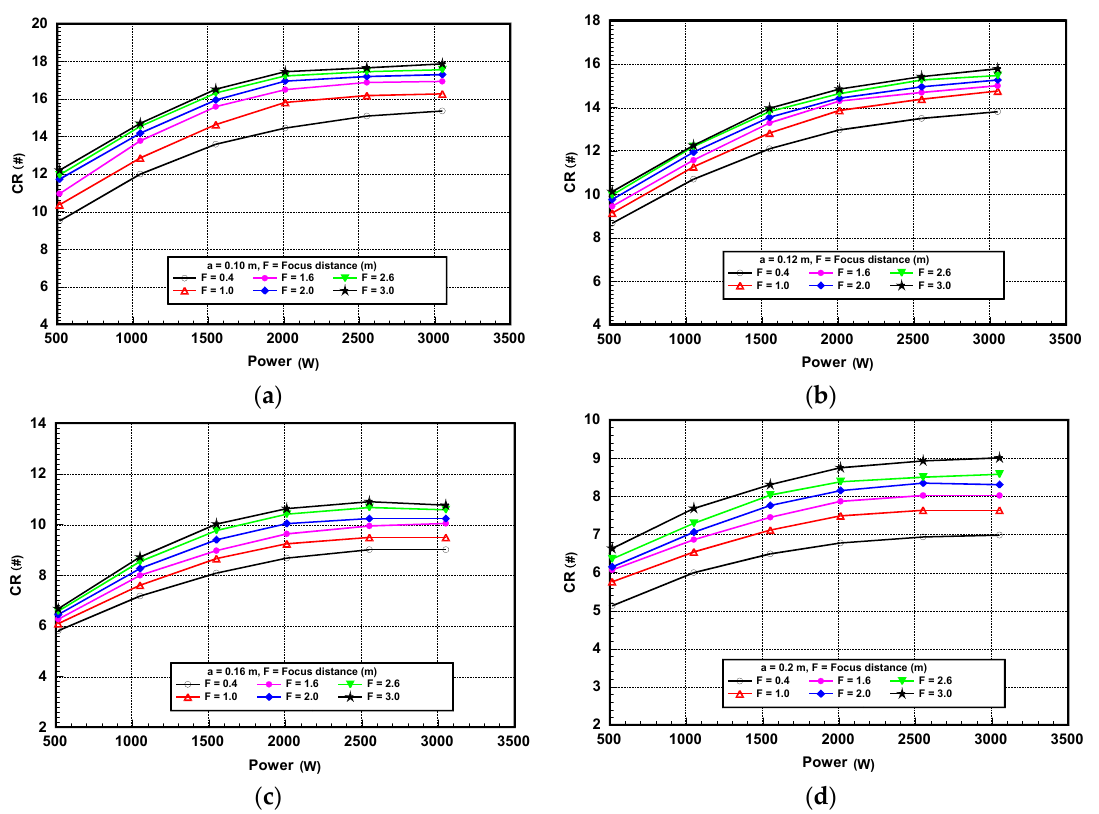
Figure 14. The concentration ratio of a CPVT collector plotted against the required power with different focus distances, ( a – d ) different receiver width.